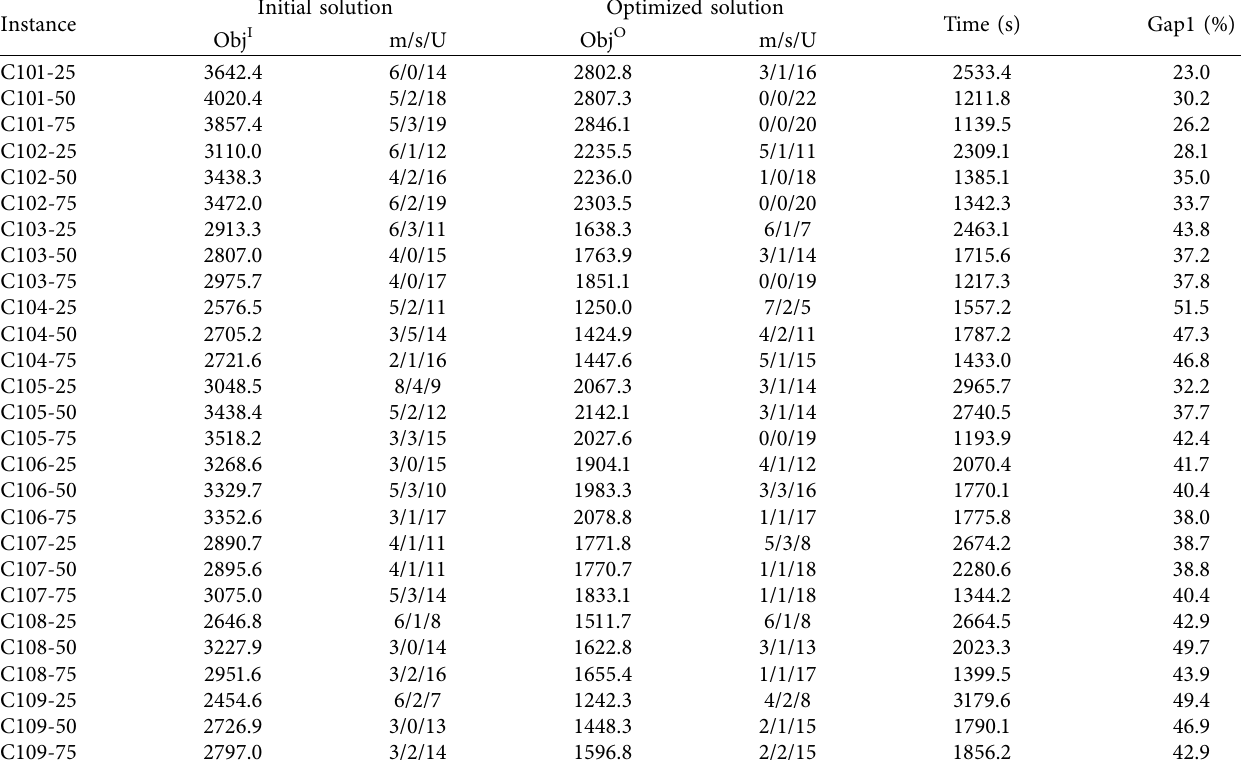
Table 6: Heuristic solutions of 27 large-scale